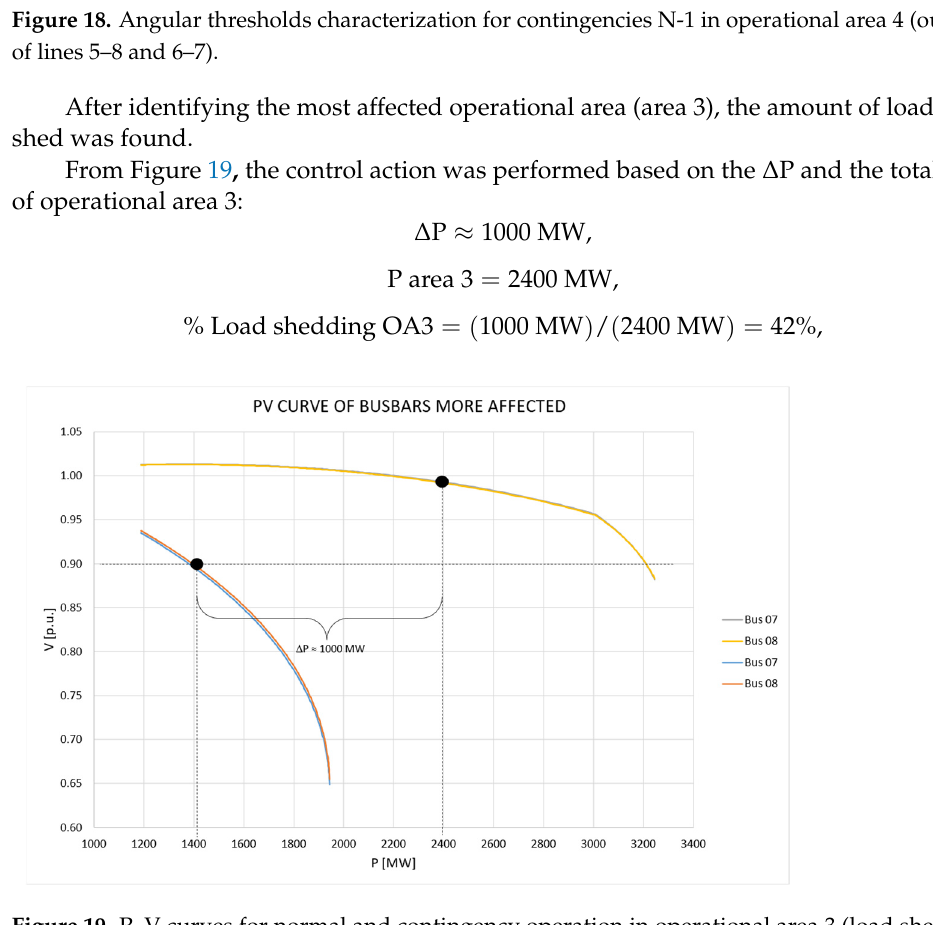
Figure 19. P–V curves for normal and contingency operation in operational area 3 (load shedding calculation).